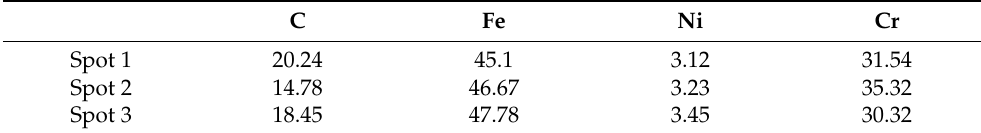
Table 4. Point scan analysis of the precipitates (wt. %).